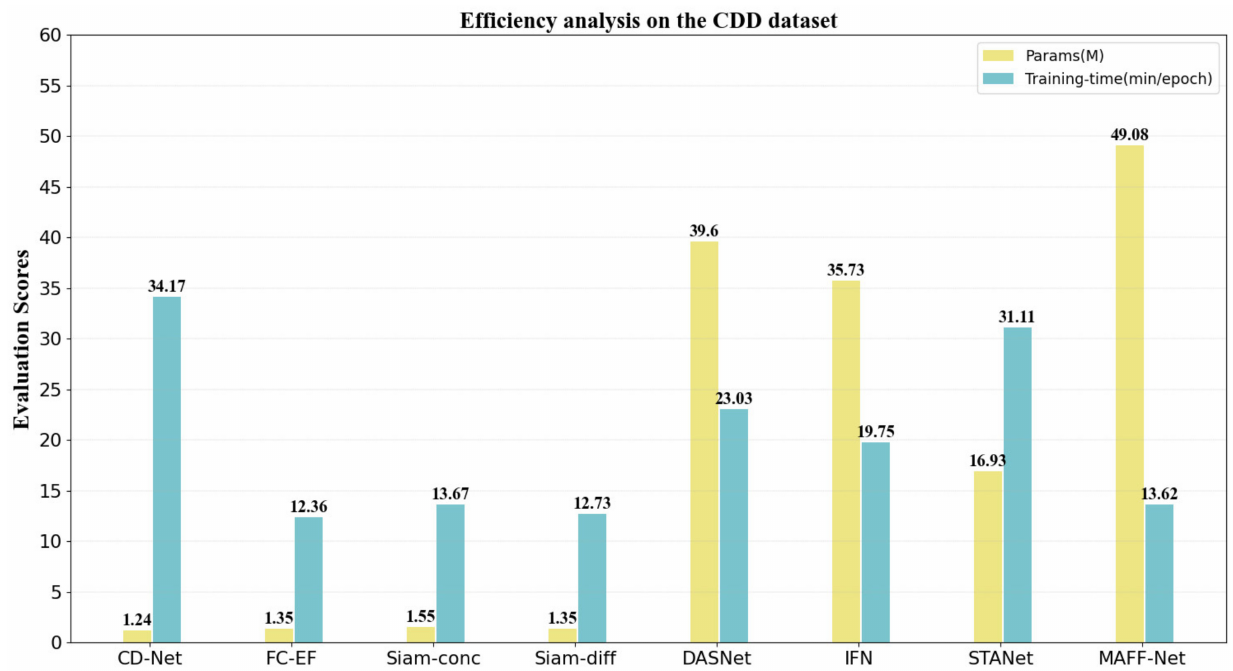
Figure 12. Illustration of an efficiency analysis of the comparison